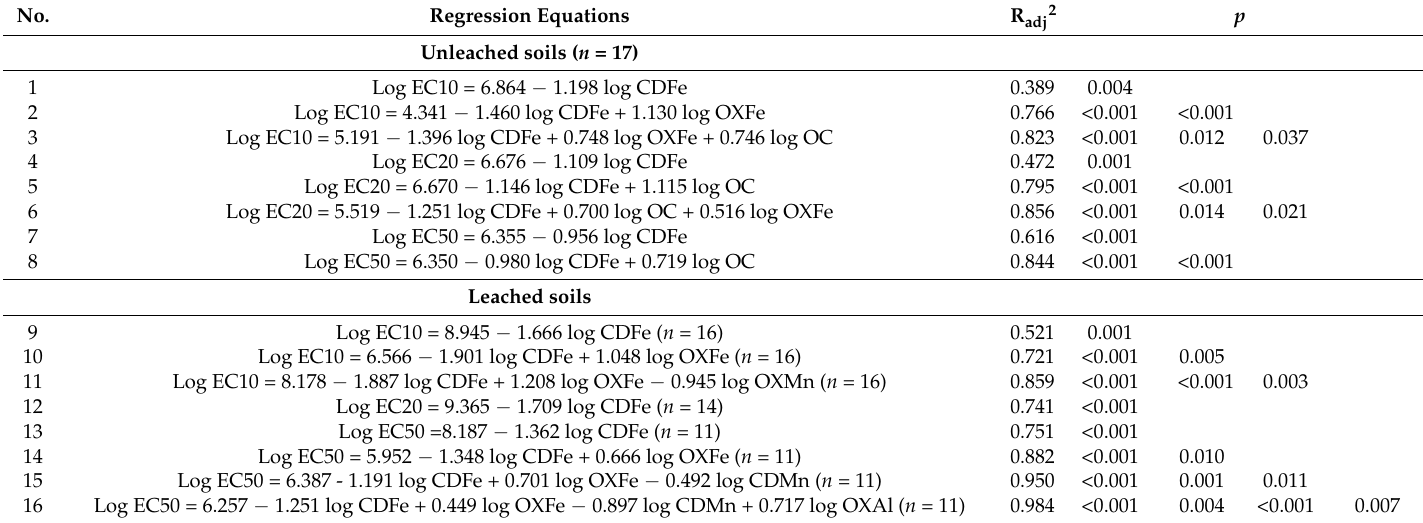
Table 6. Simple and multiple linear regressions between Ni toxicity thresholds based on extractable Ni concentrations (mg/kg) of three EDTA extractions and selected soil